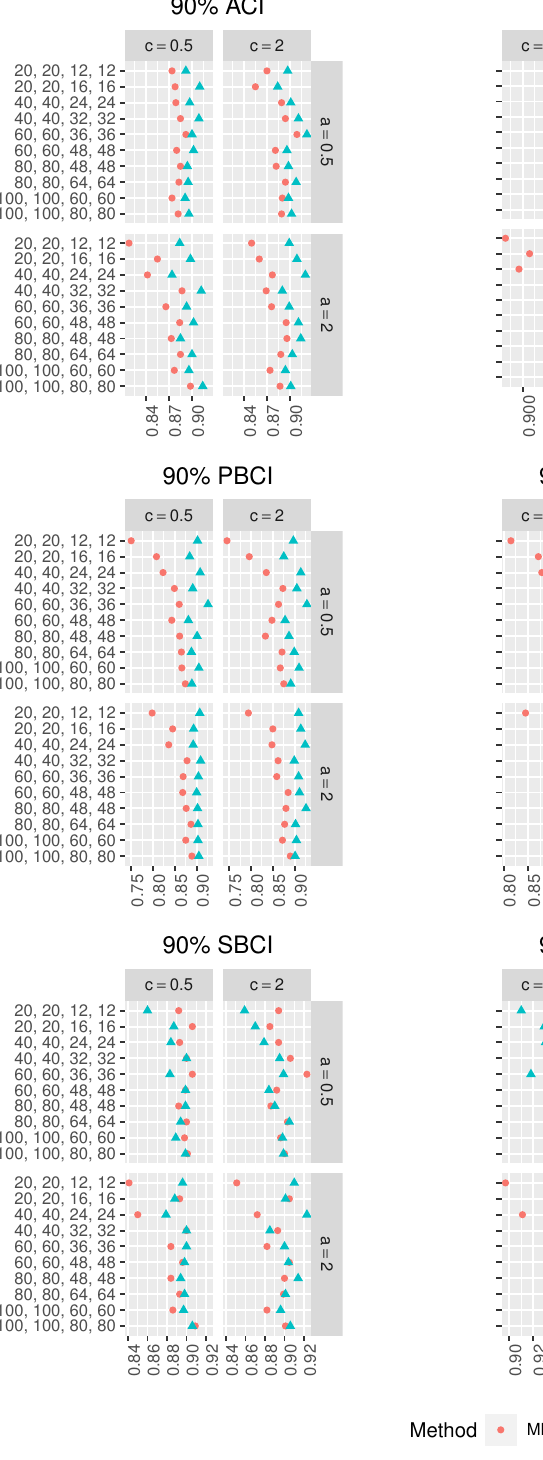
Figure 9. Simulated CPr of different CIs of b